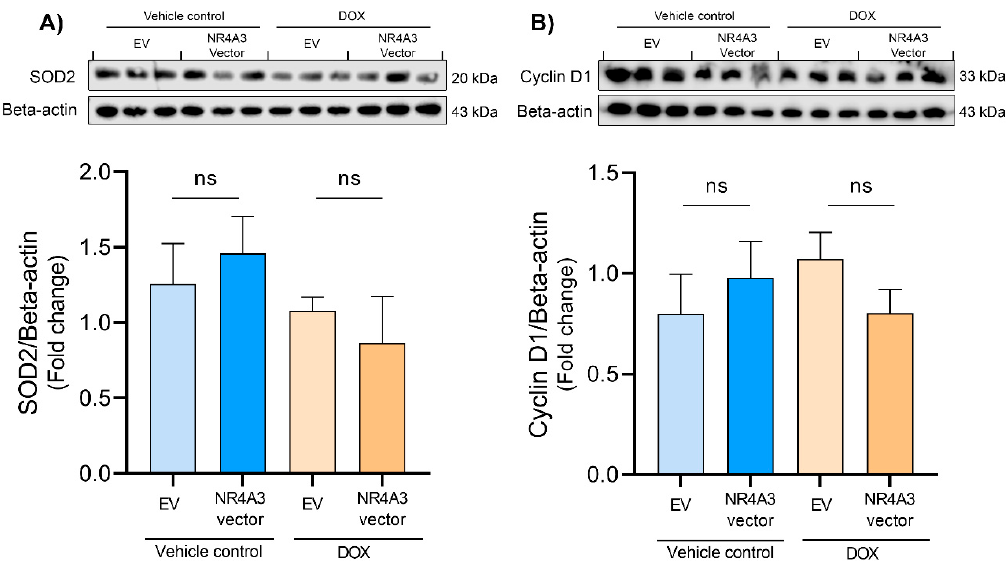
Figure 6 . Protein expression of SOD2 and Cyclin D1 measured by Western blotting. The results in ( A , B ) show that treating the CMs with 5 µM DOX for 12 h showed no effect on protein expression of SOD2 and Cyclin D1, and neither did NOR-1 overexpression. Protein expression was normalized to loading control Beta-actin in the densiometric analyses. The graphs in ( A , B ) are presented with mean ± SD ( N = 3). ns = p > 0.05 (not significant).